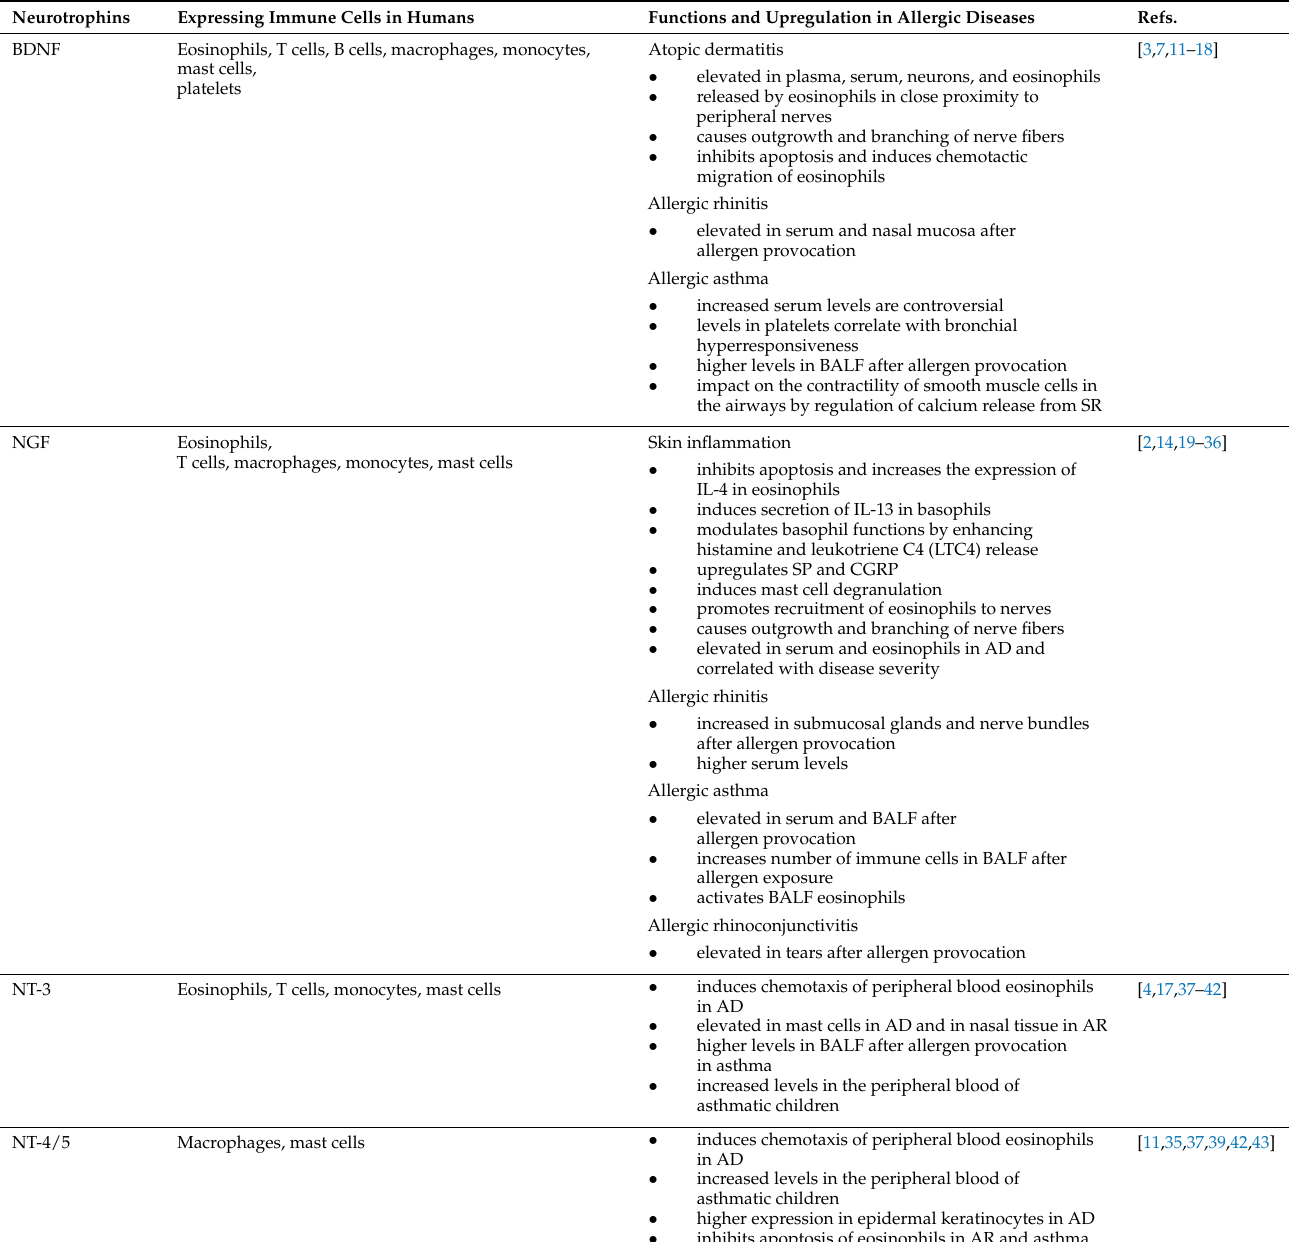
Table 1. Functions and upregulation of neurotrophins in human immune cells.